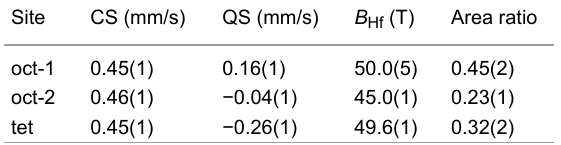
Table 1: Summary of fitted Mössbauer parameters. a